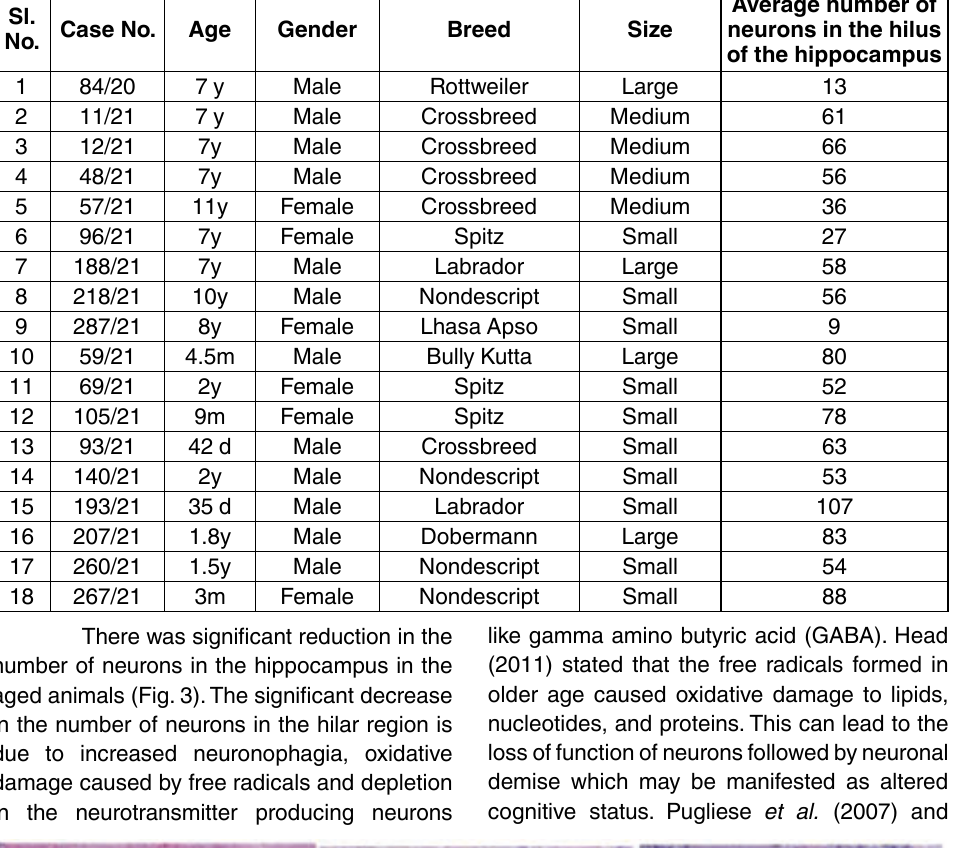
table 1. Average number of neurons in the hilar region of hippocampus sl. case No.